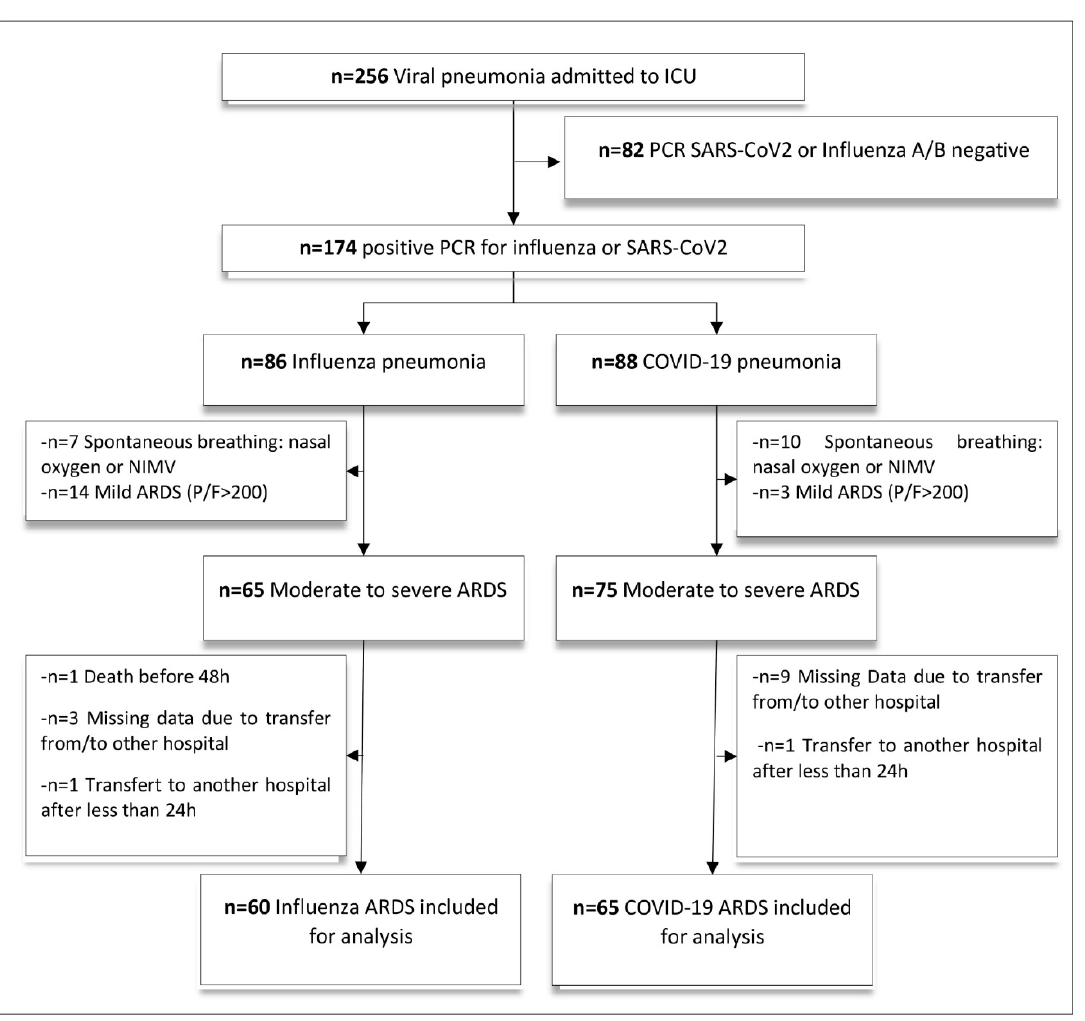
Figure 1. Flow chart of the study. 256 patients with viral pneumonia were admitted in ICU between December 2017 and April 2020. After applying inclusion and exclusion criteria, 60 confirmed H1N1 ‐ ARDS and 65 confirmed COVID ‐ 19 ‐ ARDS were included for analysis. Abbreviations: ARDS = acute respiratory distress syndrome; ICU = intensive care unit; NIMV = non ‐ invasive mechanical ventilation. Table 1. Demographics and patient’s characteristics at ICU admission.